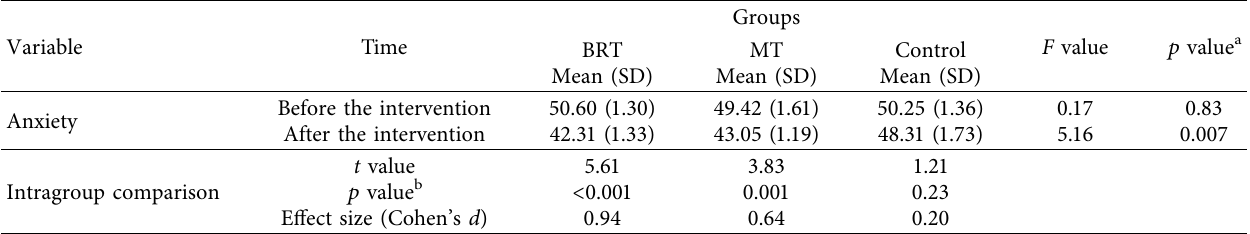
Table 2: Mean scores of anxiety before and after the interventions in the groups.